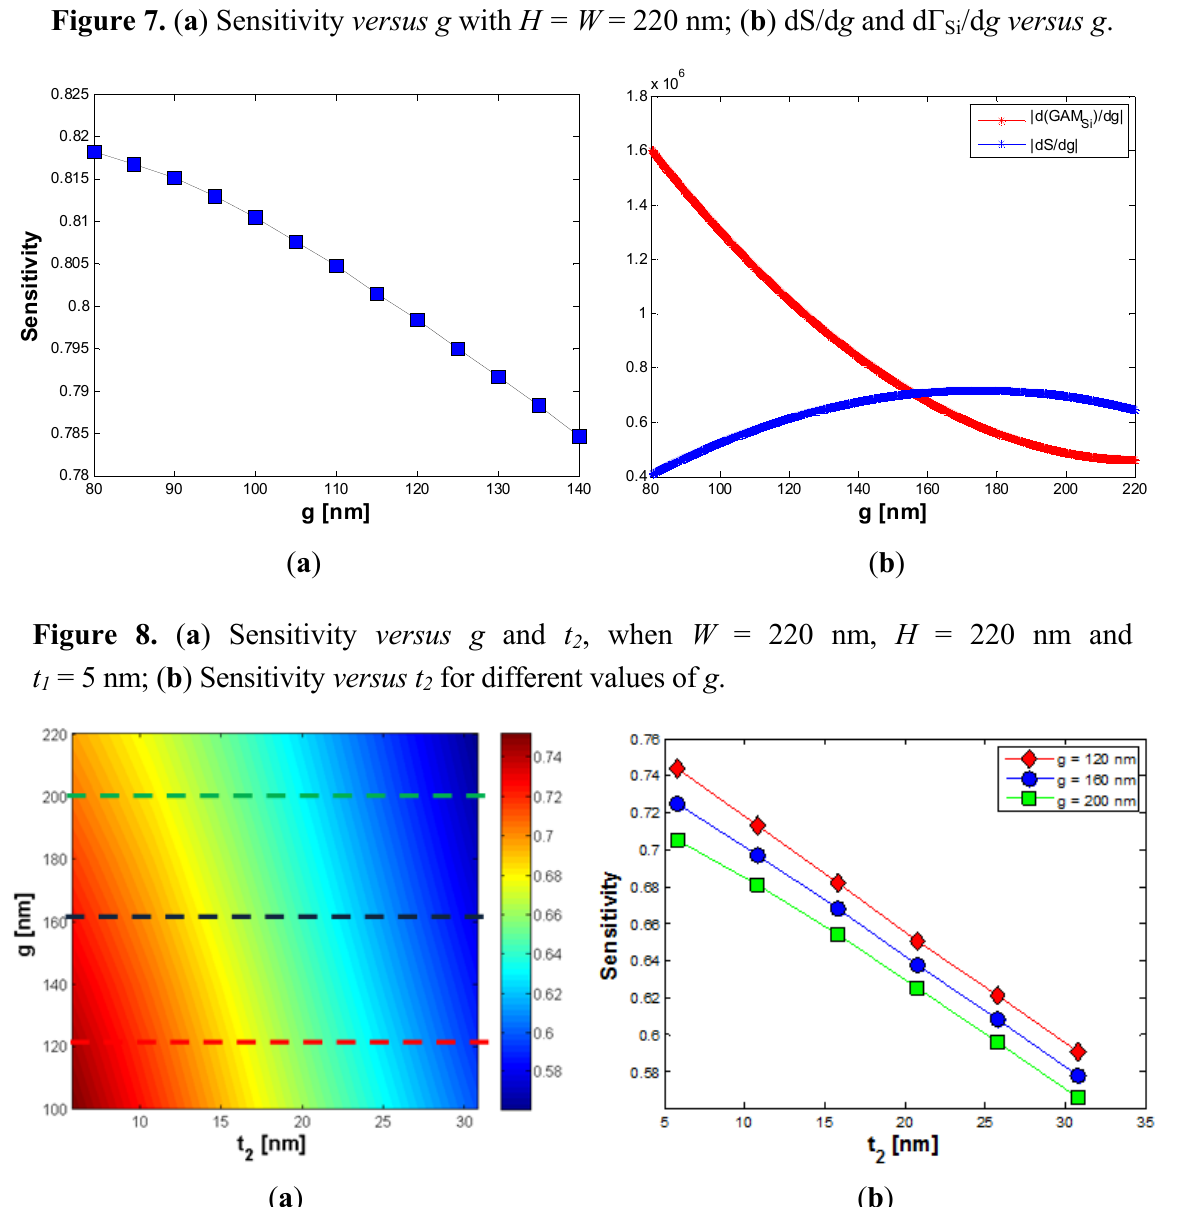
Figure 7. ( a ) Sensitivity versus g with H = W = 220 nm; ( b ) dS/d g and d Γ